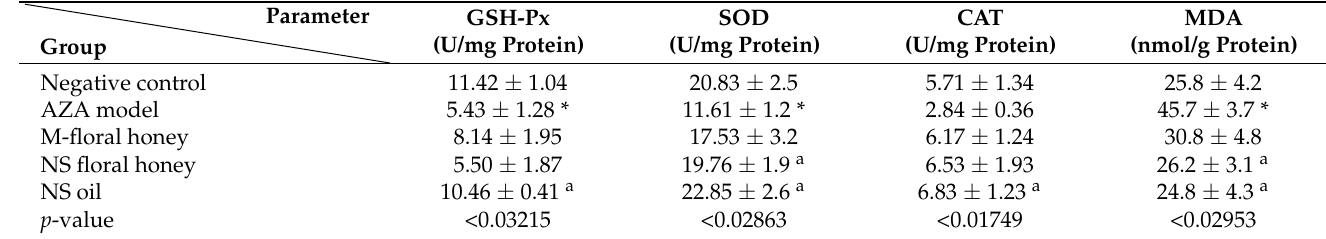
Table 5. Effects of M-floral honey, NS floral honey, and NS oil on redox balance.